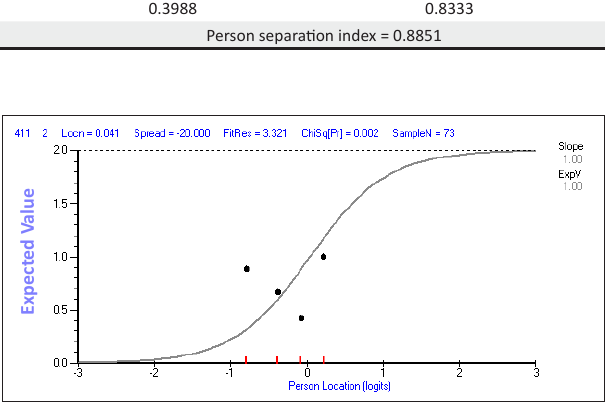
FIGURE 5: Item characteristic curve for Item 4.1.1, indicating haphazard misfit.